Question: What style of plot is this figure drawn as?
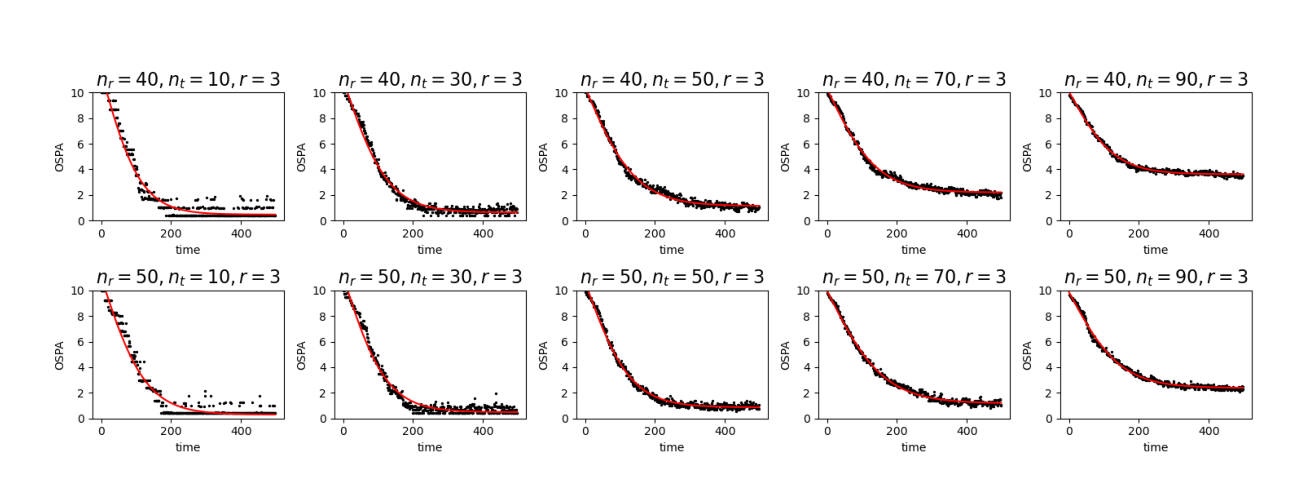
Answer: line